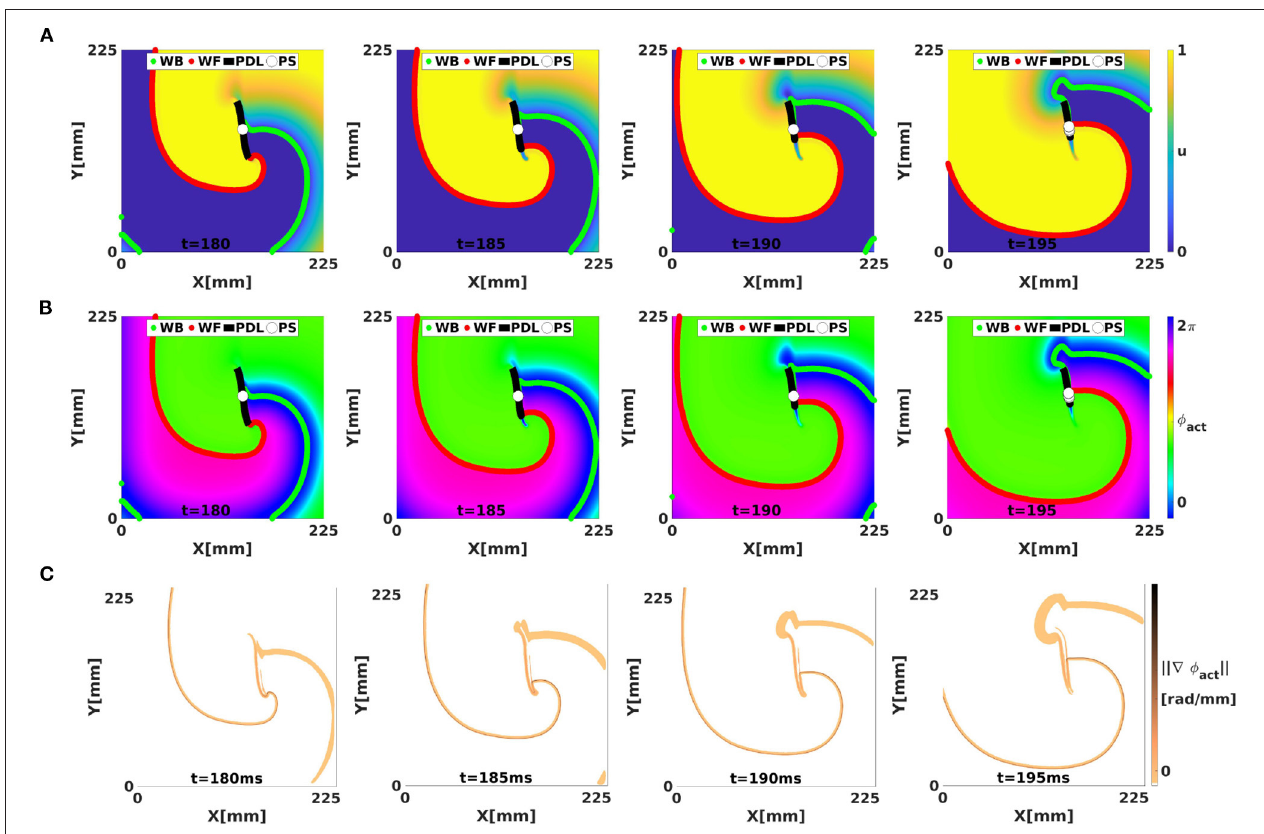
FIGURE 4 | Analysis of a simulated linear-core rotor (BOCF model) using activation phase, showing the WF, WB, classical PSs, and CBL/PDL at different times. The V WF and WB were computed as points with V with positive or negative dV / dt . The CBL/PDL was computed with Equation (4). (A) Transmembrane potential u . = ∗ The classical PS is located near the position where the WF joins the PDL. At t 195, several PSs are found near this intersection. (B) Same frames colored with the = classical activation phase, showing sudden transitions at WF, WB, and PDL, see gradient of φ act in (C)